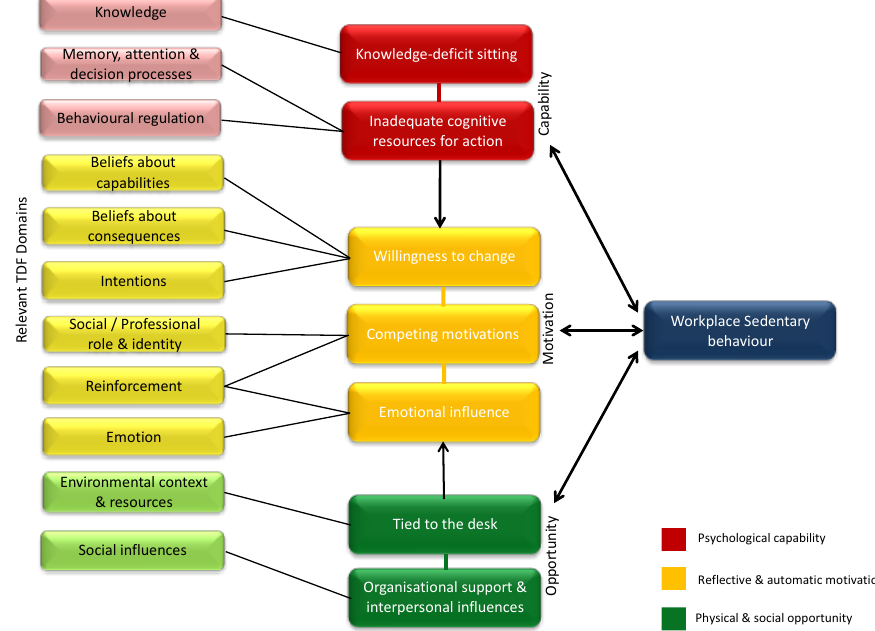
Figure 1. Qualitative themes linked to the Theoretical Domains Framework (TDF) and Capability, Opportunity and Motivation—Behaviour model (COM-B) as determinants of workplace sedentary